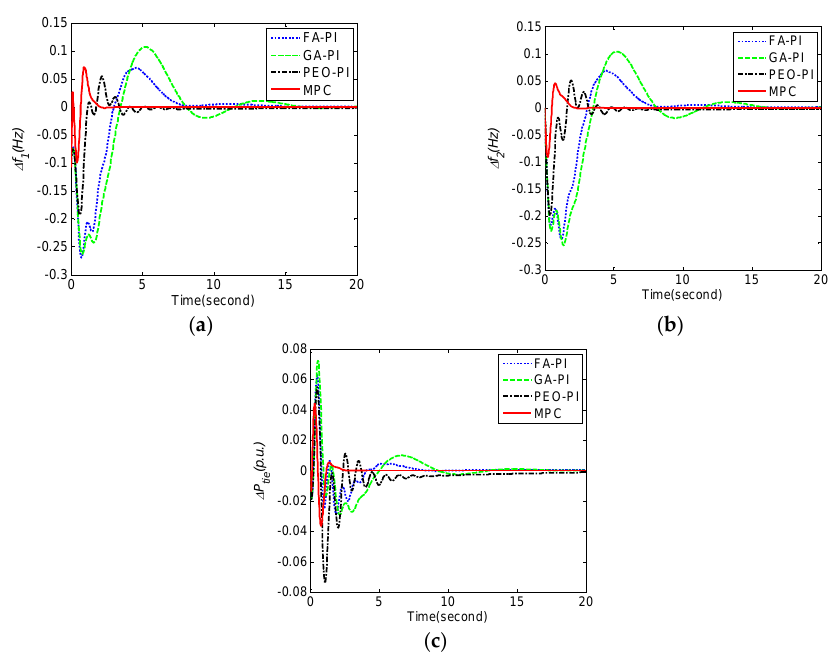
Figure 7. Comparison of frequency deviations ∆ f 1 , ∆ f 2 and tie line power deviation ∆ P tie obtained by different control methods under T g decreasing 40%for case 3. ( a ) frequency deviation ∆ f 1 ; ( b ) frequency deviation ∆ f 2 ; ( c ) tie line power deviation ∆ P tie .